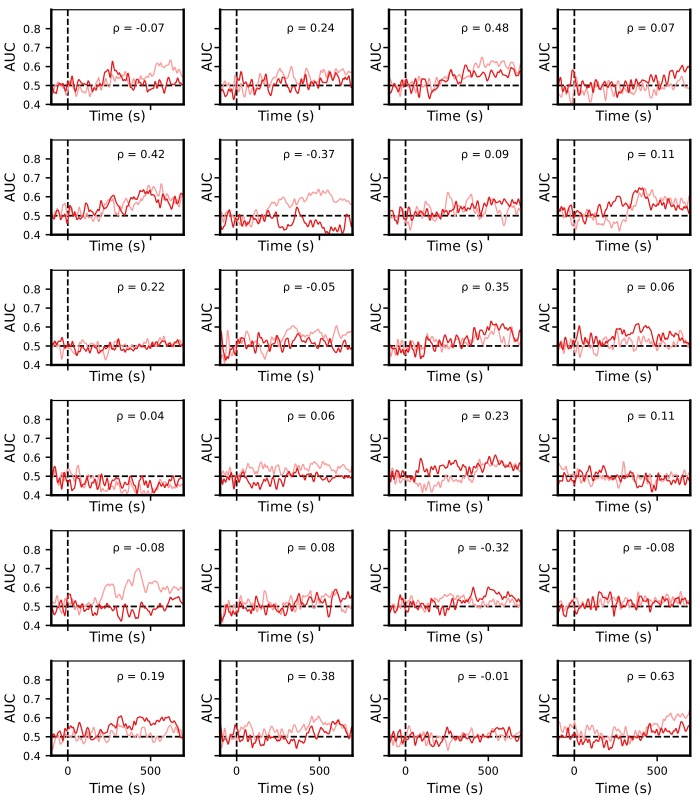
Classification performance in the 2TMP-2TGT condition, separately for horizontal and vertical targets for each participant and individual correlation scores of classifier confidence scores between vertical and horizontal targets.Individual MVPA decoding performance for target positions on the horizontal (left vs. right, less saturated red line) and on the vertical meridian (top vs. bottom, more saturated red line) in the 2TMP-2TGT condition (which is the condition where we expected serial processing, if any, to be most prominent). For each individual, we computed Spearman’s ρ correlation between the classifier performances in the time window from 150 ms to 700 ms post stimulus (the values of which are shown in each plot). For visualization purposes only, the classification scores over time were fitted with a cubic spline (λ = 15, comparable to a 30 Hz low-pass filter) to achieve temporal smoothing. Note that the correlations were performed on unsmoothed data. See also Figure 3—figure supplement 1—source data 1 and 2.10.7554/eLife.49130.013Figure 3—figure supplement 1—source data 1.Time series data of classifier confidence for horizontal targets in the 2TMP-2TGT condition per participant, as shown in Figure 3—figure supplement 1.10.7554/eLife.49130.014Figure 3—figure supplement 1—source data 2.Time series data of classifier confidence for vertical targets in the 2TMP-2TGT condition per participant, as shown in Figure 3—figure supplement 1.